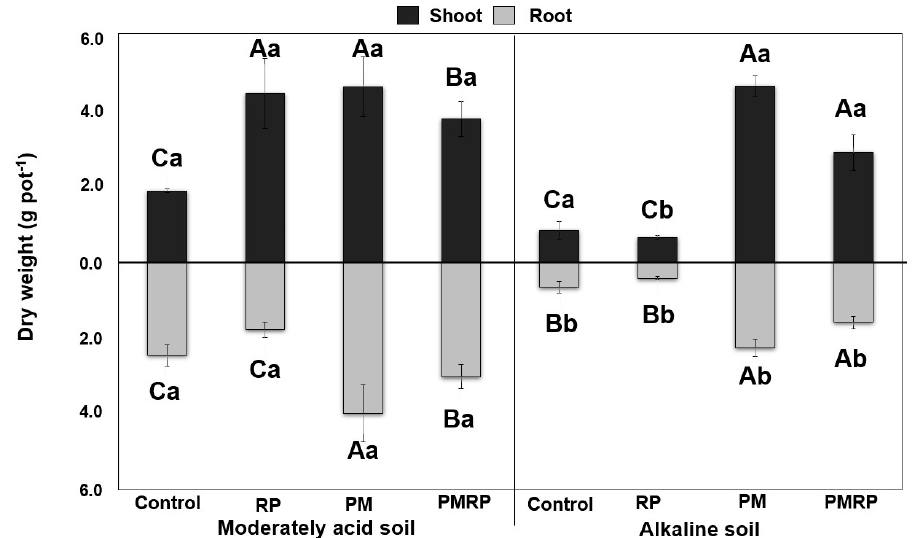
Figure 3. Dry weight of shoots and roots in control and soil amended with poultry manure compost (PM), phosphate rock (RP), and their combination (PMRP) after 7 weeks of ryegrass growth. Upper case letters denote significant differences ( p ≤ 0.05) between treatments for one soil. Lower case letters denote significant differences ( p ≤ 0.05) between soils for one treatment.